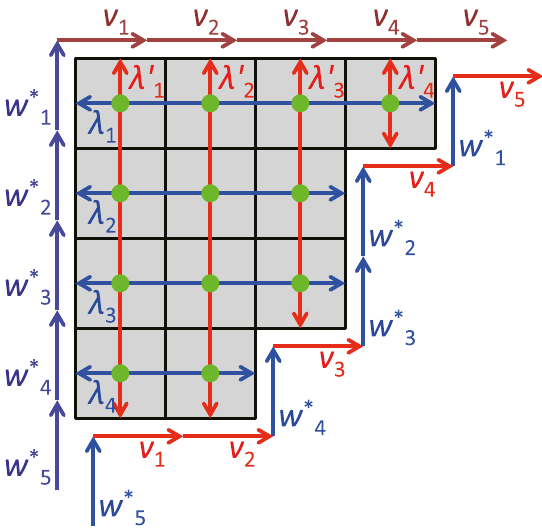
Figure 5 . Example of the product v 5 w (cid:3) ward arrows and the rightward arrows and connect them successively. (cid:21) i and (cid:21) 0 tively the deviations from the product in the reference order v 5 v 4 v 3 v 2 v 1 w (cid:3) are the horizontal and vertical lengths of the displacements, [ (cid:21) 1 ; (cid:21) 2 ; (cid:21) 3 ; (cid:21) 4 ; (cid:21) 5 ] = [4 ; 3 ; 3 ; 2 ; 0] and [ (cid:21) 0 ; (cid:21) 0 ; (cid:21) 0 ; (cid:21) 0 ; (cid:21) 0 ] 0 = [4 ; 4 ; 3 ; 1 ; 0] 0 . The sign of the permutation can be found by counting the inter- 1 2 3 4 5 sections of arrows (green dots) showing the displacements, which is in one-to-one correspondence with the boxes where the intersections are